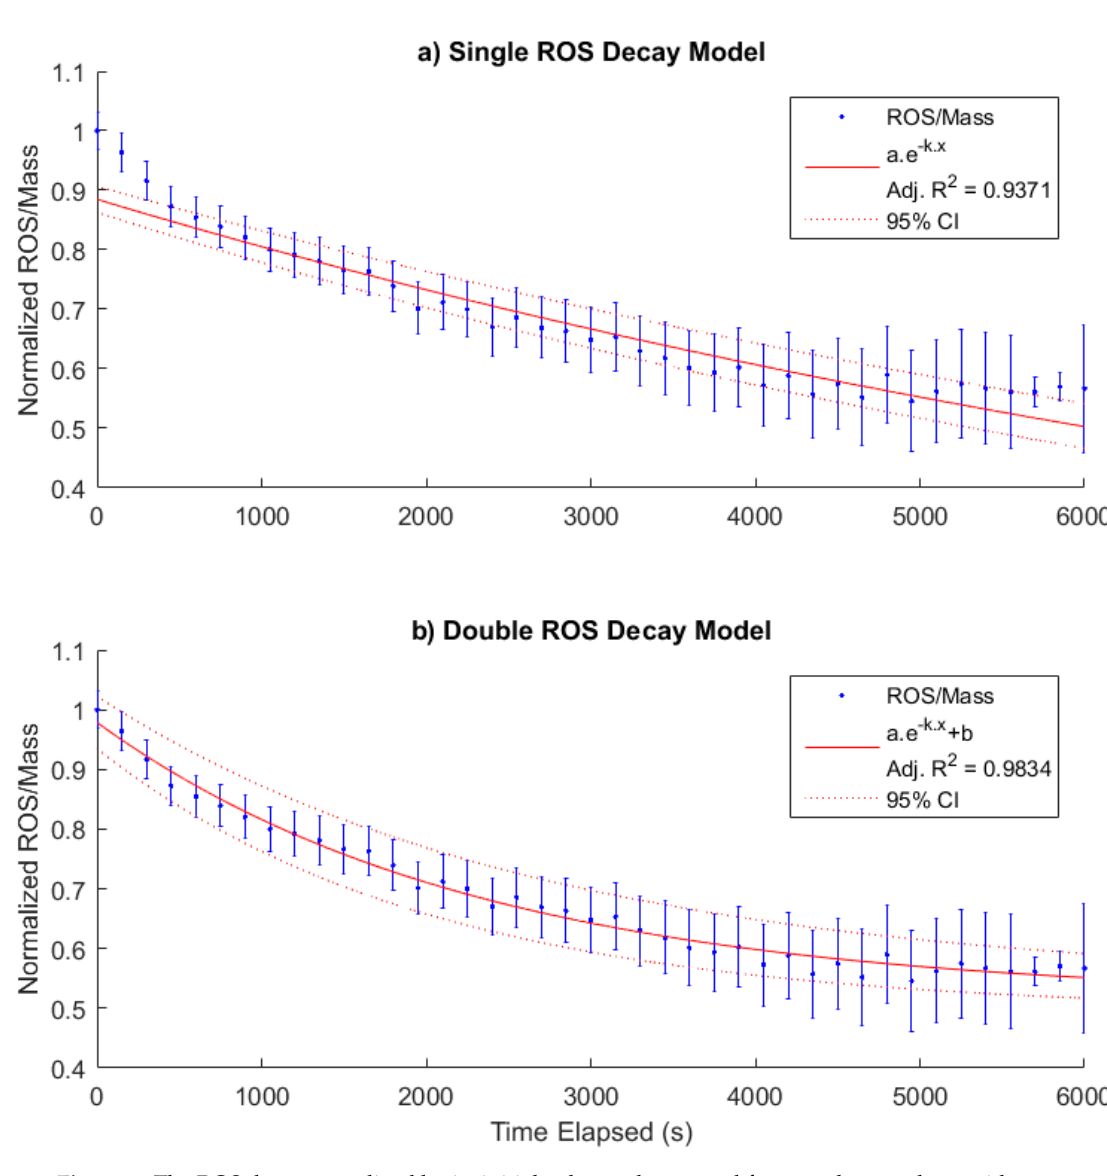
Figure 5. The ROS data, normalized by its initial value and corrected for mass losses, along with two different fitted curves to the ROS data using different assumptions of ROS decay. ( a ) shows a fit which assumes that all ROS present have a single half-life, with a value calculated from the fit of 120 min with a 95% confidence interval (CI)(110,140). This model does not fit well at low or high elapsed times. ( b ) shows a fit which assumes there are two subsets of ROS, in which the second set has a lifetime which is effectively infinite over the measurement period. The half-life of the short-lived ROS using this model is 27 min with a 95% CI(23,31).